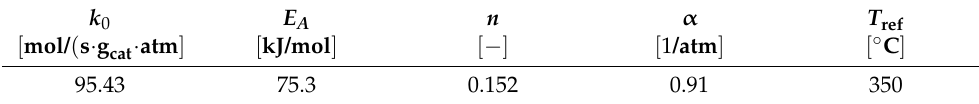
Table 1. Kinetic parameters for reactor modeling. Extracted from Falbo, et al. [34].